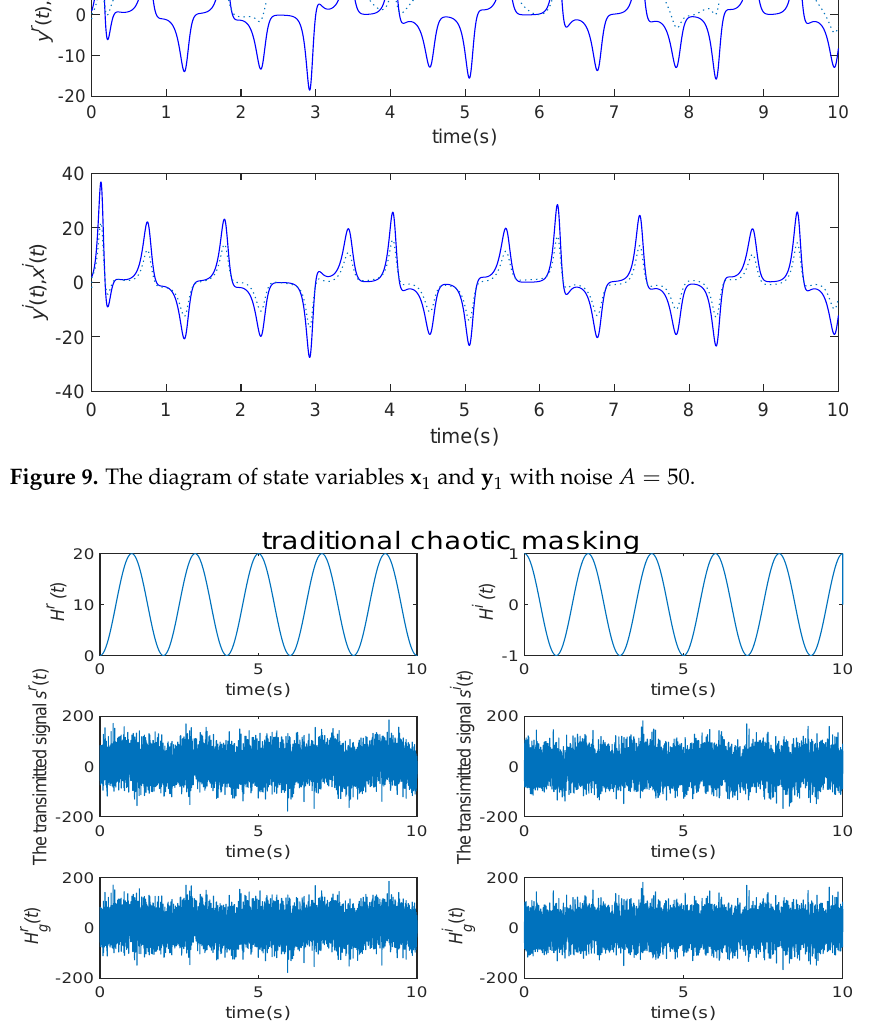
Figure 10. The traditional chaotic masking process with noise A = 50 and the same control